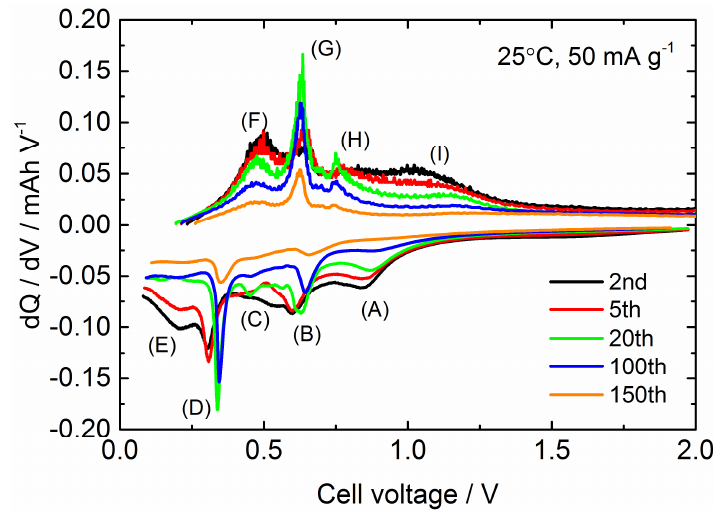
Figure 8. Di ff erential capacity d Q / d V ( Q : capacity, V : cell voltage) curves for the Sn 4 P 3 / C composite Figure 8. Differential capacity d Q /d V ( Q : capacity, V : cell voltage) curves for the Sn 4 P 3 /C composite film calculated from the data for galvanostatic cycling film calculated from the data for galvanostatic cycling test.